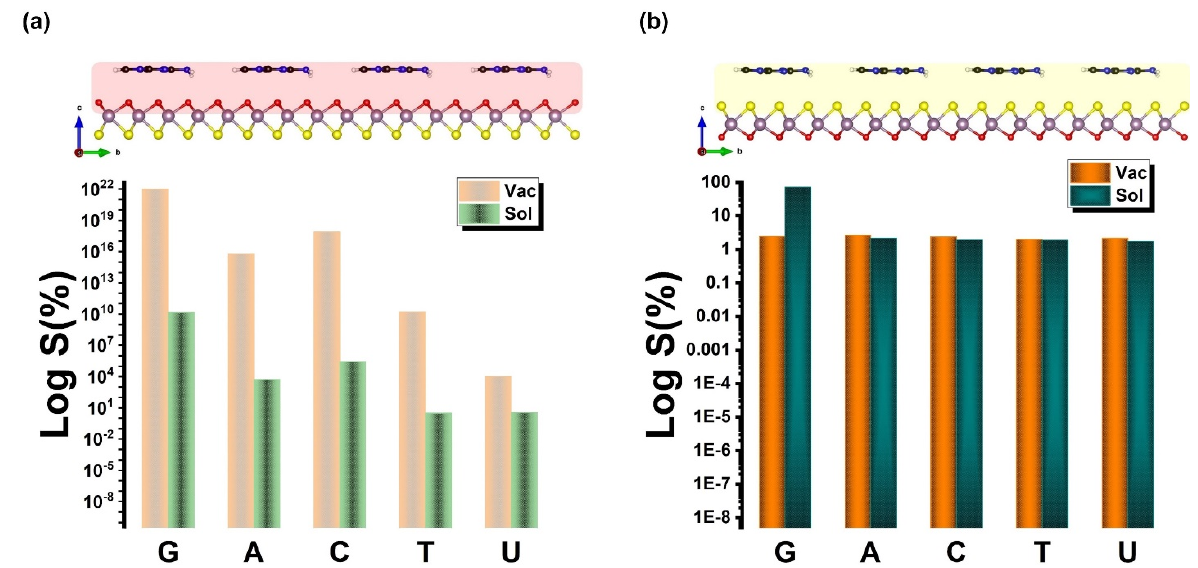
Figure 9. The sensitivity of the nucleobases molecules on the Janus MoOS monolayer facets at T = 298 K, ( a ) on O layer, ( b ) on S layer, respectively.